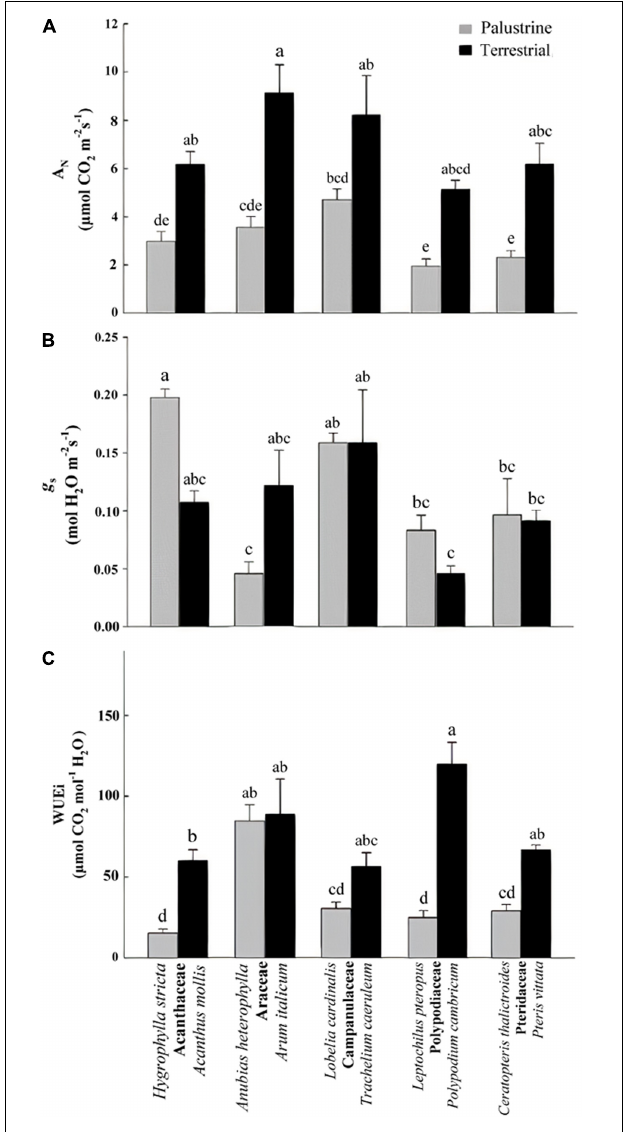
FIGURE 2 | (A) Net photosynthesis (A N ), (B) stomatal conductance ( g s ), and (C) intrinsic water-use efficiency (WUEi) in all palustrine and terrestrial species tested in this study. In (C) , values were calculated from mean values of A N and g s . Four to six plants were used to characterize each species. Different letters indicate significant differences with a p -value < 0.05 determined by a post hoc Tukey–Kramer’s test.